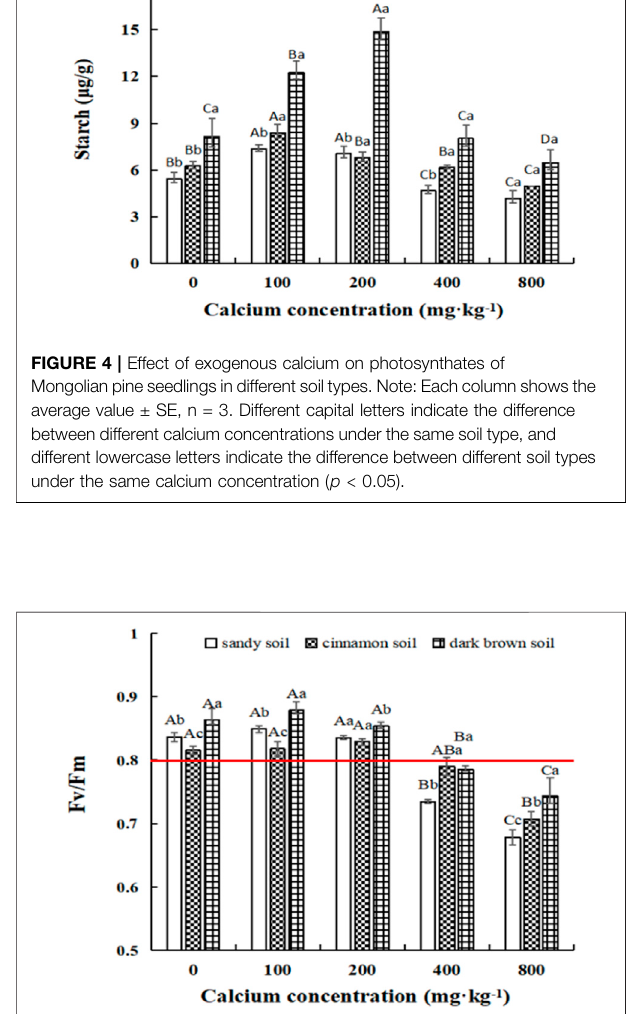
FIGURE5| Effects ofexogenouscalciumon chlorophyll fl uorescence of Mongolian pine seedlingsin different soil types. Note: Each column shows the average value ± SE, n = 3. Different capital letters indicate the difference between different calcium concentrations under the same soil type, and different lowercase letters indicate the difference between different soil types under the same calcium concentration ( p <